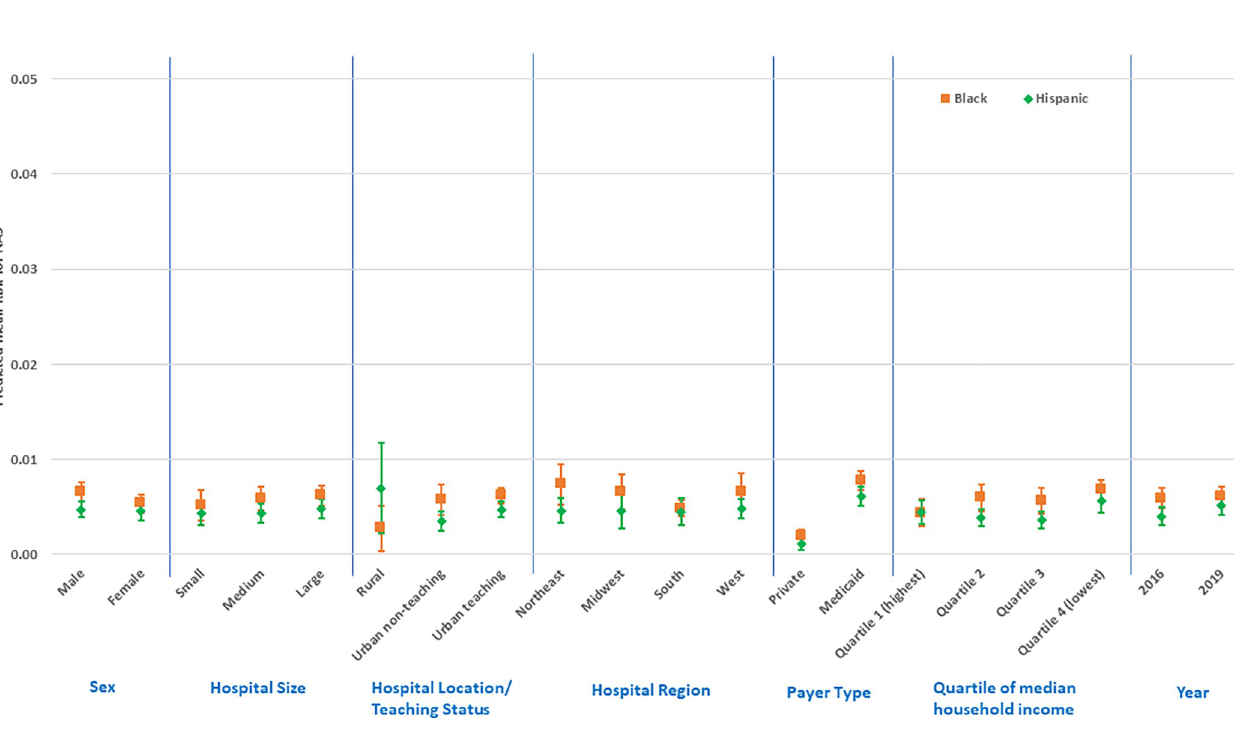
PLOS ONE | https://doi.org/10.1371/journal.pone.0284040 April 5, 2023 7 /